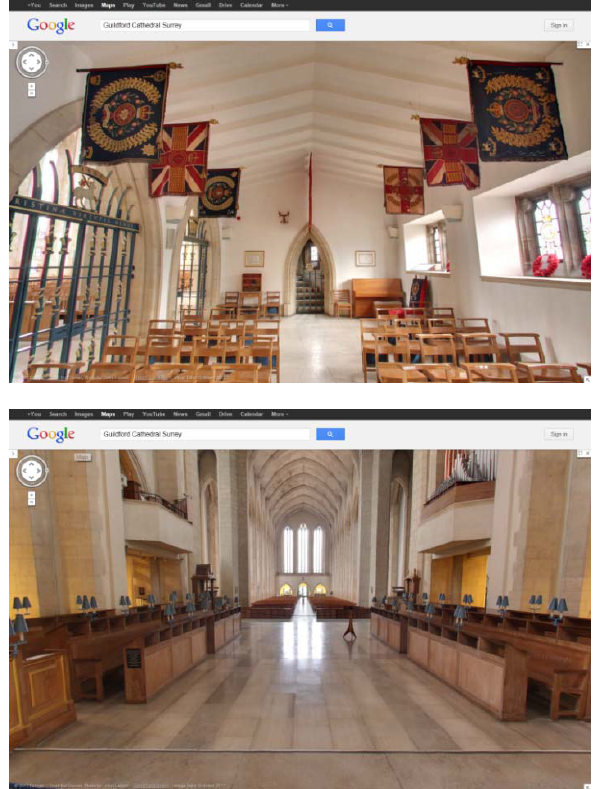
Figure 38: Interiors of Guildford Cathedral, showing the indoor online possibilities of Google’s Street View. A full walk about is very possible. Google Guildford